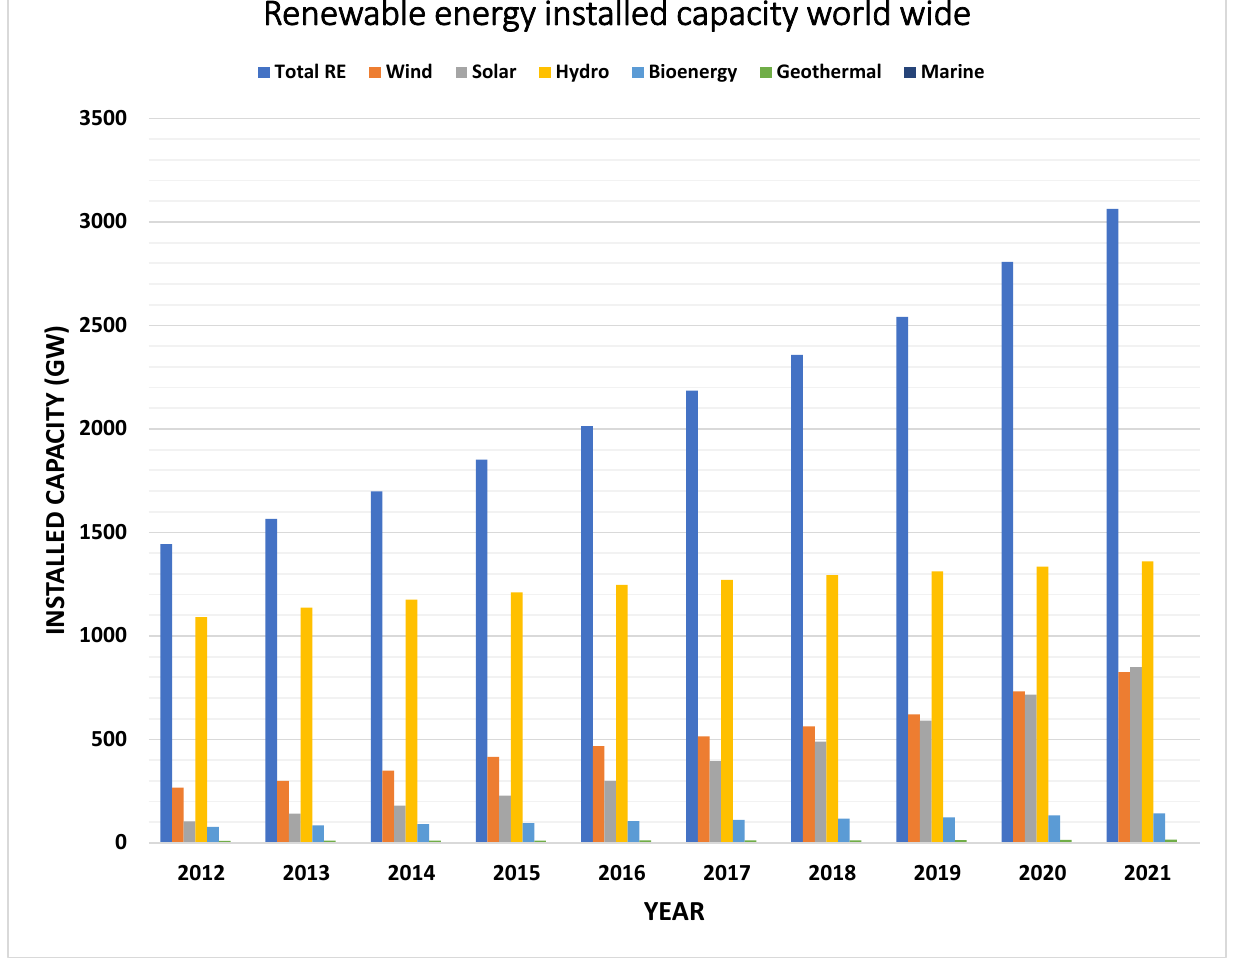
Figure 1. Total RER installed capacity during 2012–2021.